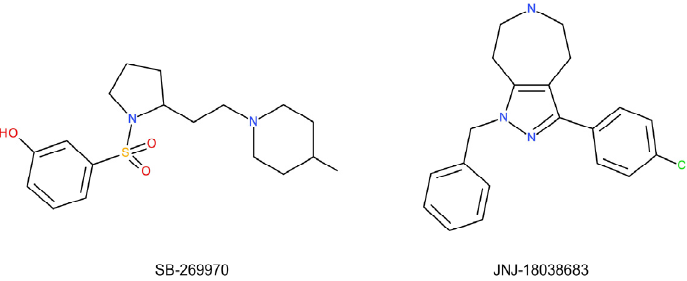
Figure 10. 5-HT 7 receptor antagonists: SB-269970 and